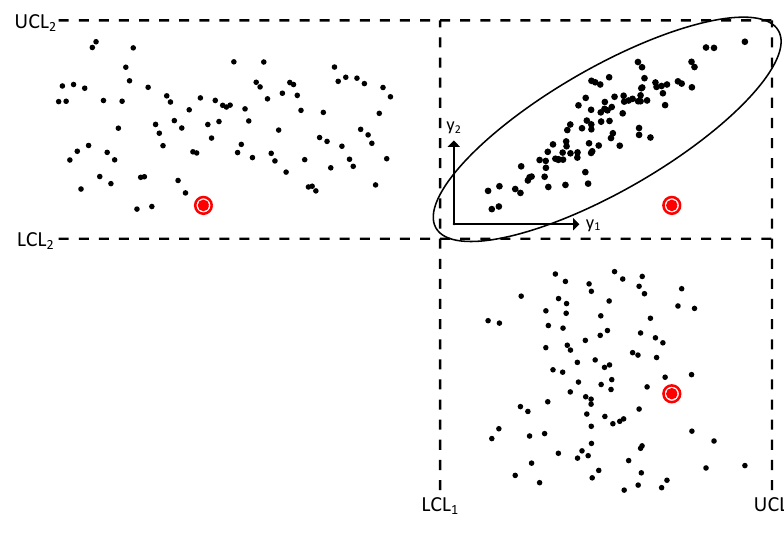
Figure 3. Univariate control limits suffer from “blind spots” in a multivariate setting: a data sample (marked in red) can be within the control limits from the perspective of every variable on the respective univariate control charts, but fall outside the multivariate confidence region. LCL and UCL represent univariate lower and upper control limits, respectively.